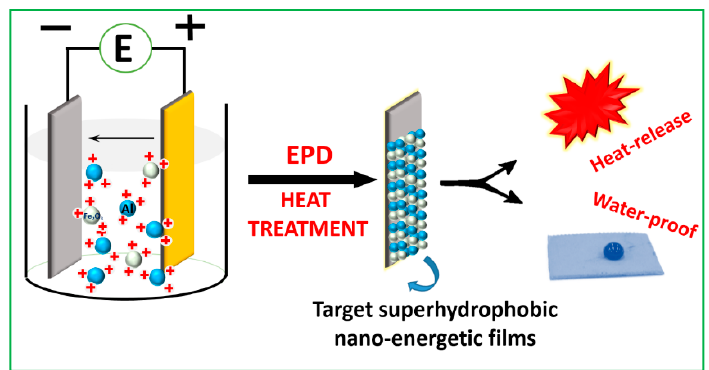
Figure 1. Schematic diagram of the preparation of the superhydrophobic nano-Al/Fe 2 O 3 films (SAFFs) by a novel one-step process.